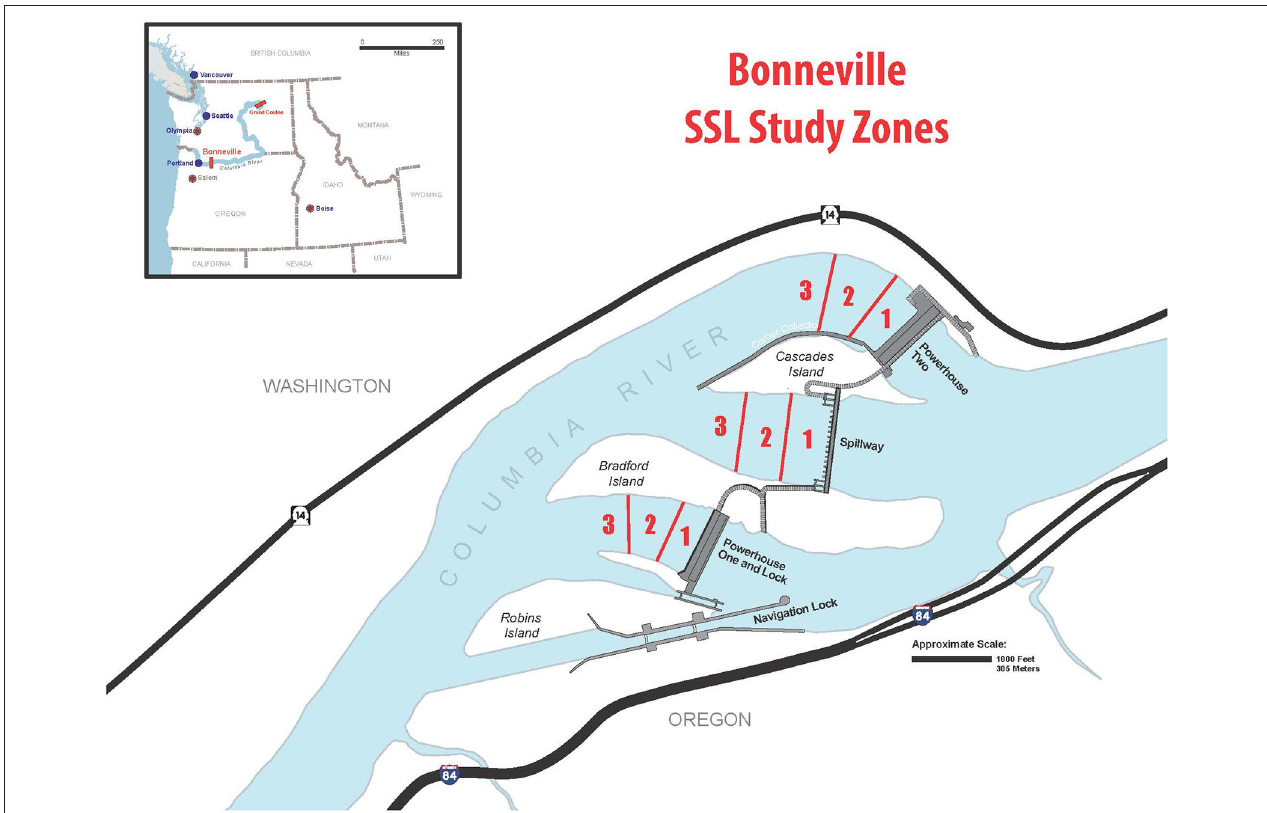
FIGURE 1 | Bonneville Dam study area. Zones used to assign the location of Steller Sea Lions during study are defined. Observers and hazers stood on the dam and implemented study protocols on sea lions in the water of each